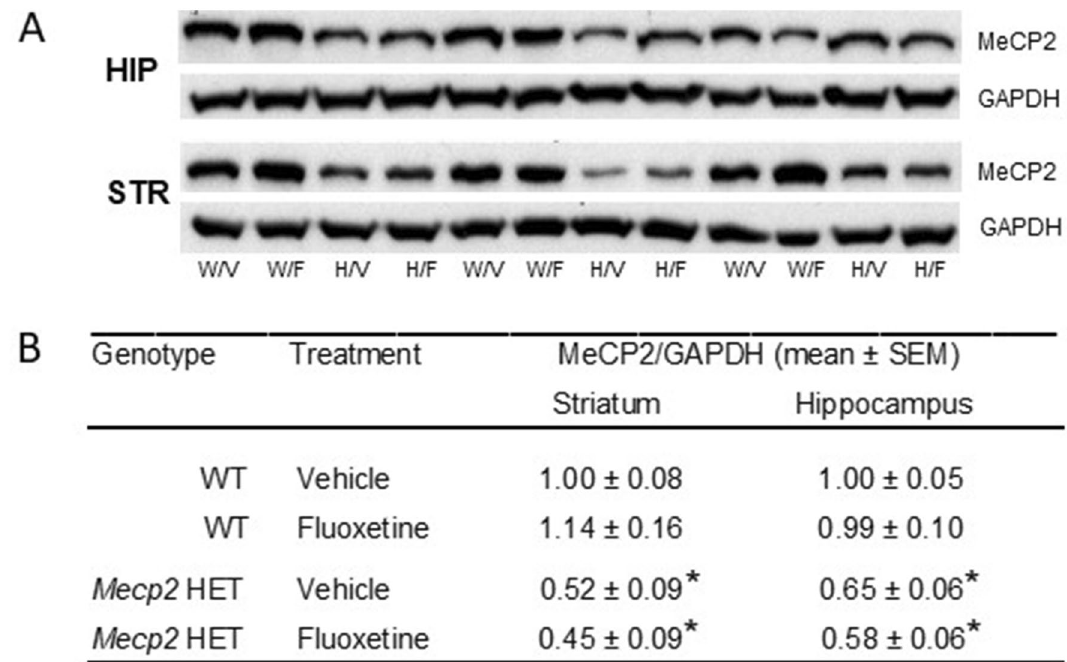
Figure 6. Effect of fluoxetine on MeCP2 levels in the striatum and hippocampus of WT and Mecp2 HET mice. ( A ) Representative immunoblots (full-length blot) of the MeCP2 and GAPDH proteins. Membranes were cut approximately in correspondence to the 50 kDa MW. The half membrane containing proteins heavier than 50 kDa was incubated with primary antibody against MeCP2, while the half membrane containing proteins lighter than 50 kDa was incubated with the antibody against GAPDH. W/V and W/F indicate WT mice receiving respectively vehicle and fluoxetine. H/V and H/F indicate Mecp2 HET mice receiving vehicle and fluoxetine. ( B ) Normalized MeCP2 expression (mean ± SEM of 5–6 mice per group) in wild type (WT) and Mecp2 HET mice receiving fluoxetine or vehicle. HIP hippocampus, STR striatum. * P < 0.05 versus respective WT control group (Tukey–Kramer’s